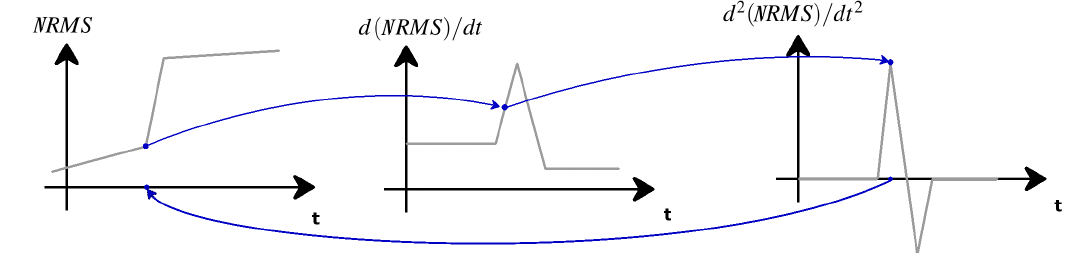
Figure 9. Evaluation of the lower angle in the step of the NRMS